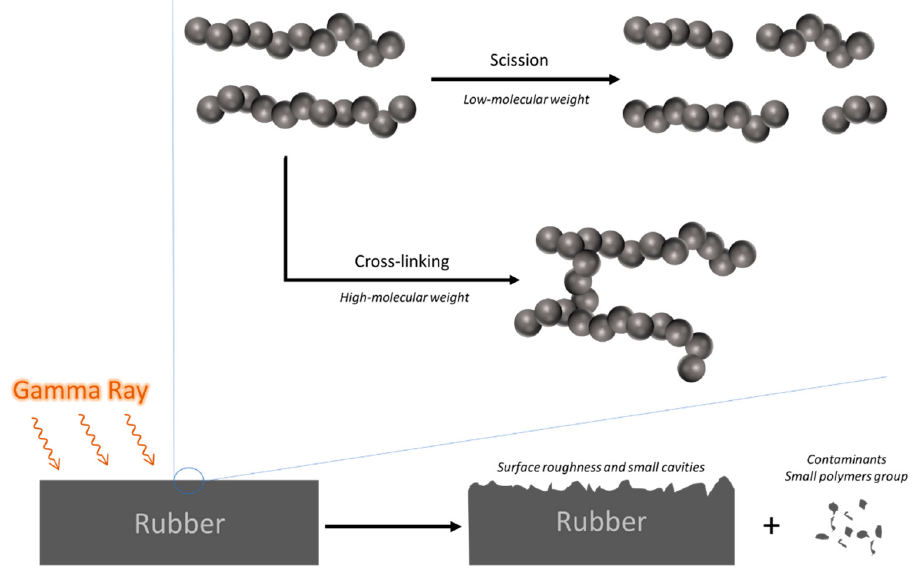
Figure 4. Simplified scheme of the gamma ray reaction initiation and effect on rubber surface.